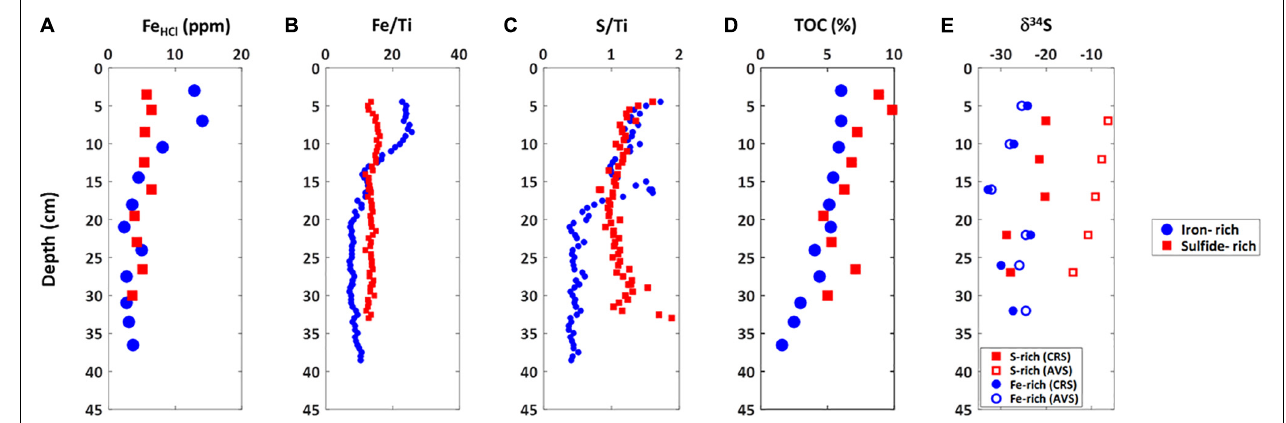
FIGURE 4 | Solid phase profiles of iron-rich (blue circles) and sulfide-rich sediment (red squares) cores taken from Norfolk in October 2014. (A) Reactive iron, (B) Iron to titanium ratio, (C) Sulfur to titanium ratio, (D) total organic carbon, (E) Sulfur isotope ratio in AVS and